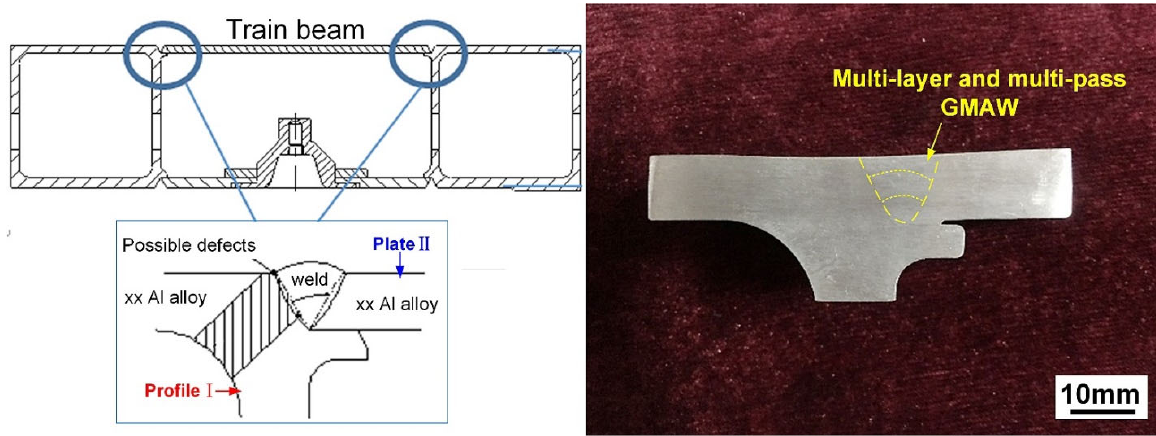
Figure 15. Aluminum alloys pillow beam in China Railway High ‐ Speed trains.